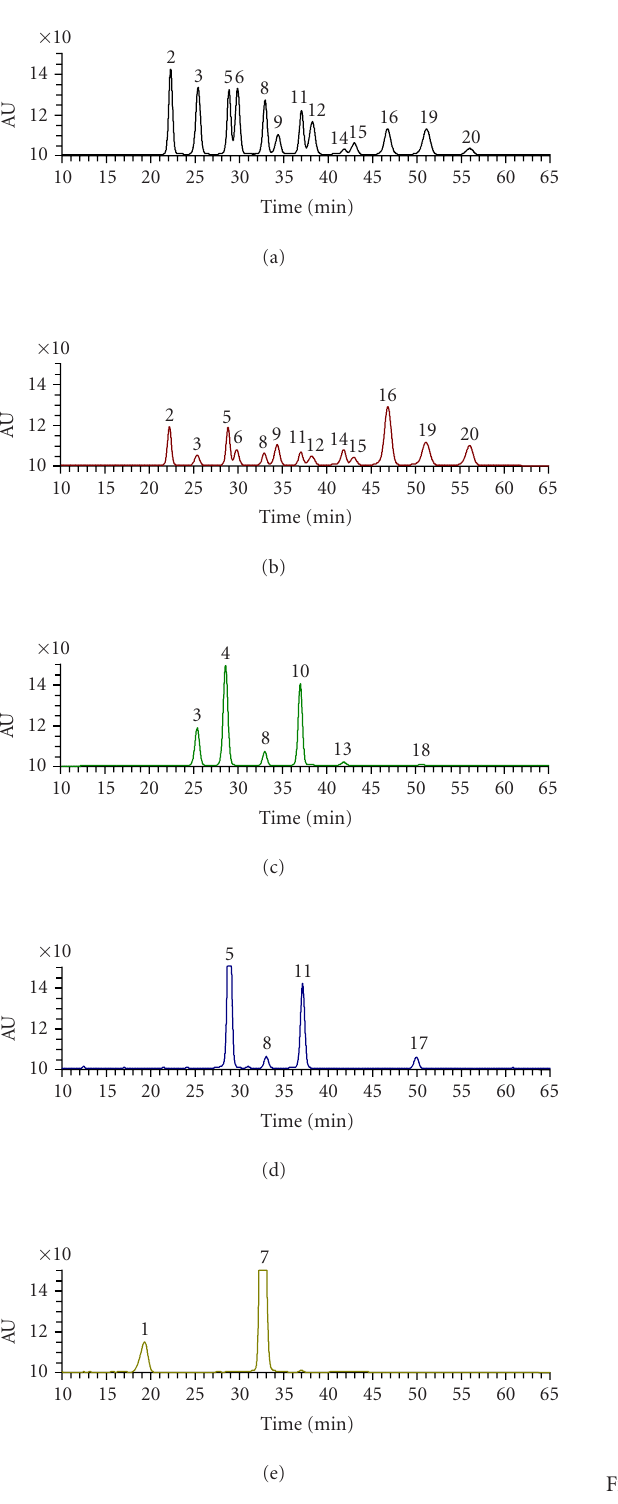
Figure 2. HPLC chromatogram of berry extracts on PDA. The chromatograms were obtained on PDA of selective wavelength (500 to 550 nm). Numbers on the chromatograms indicate de- tected peak numbers corresponding to the numbers in Table 1. (a) Bilberry; (b) Rabbiteye; (c) Black currant; (d) Chokeberry; (e) Elderberry.